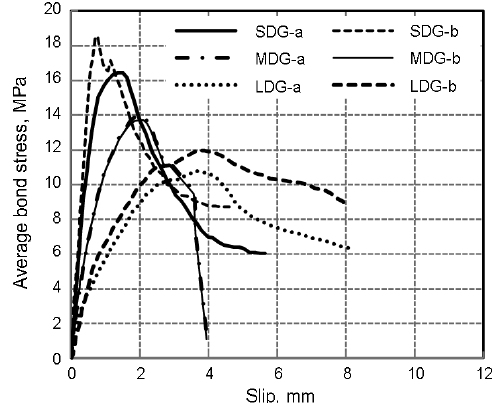
Fig. 10. Average bond stress-slip curves in specimens with GFRP bars bonded with epoxy